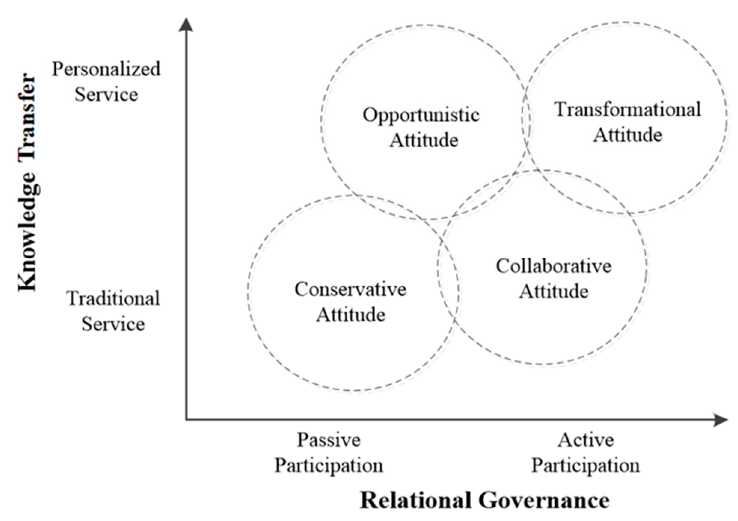
Figure 2. Relational strategic behaviors (or attitudes) in IT outsourcing according to Poleto et al. [29].